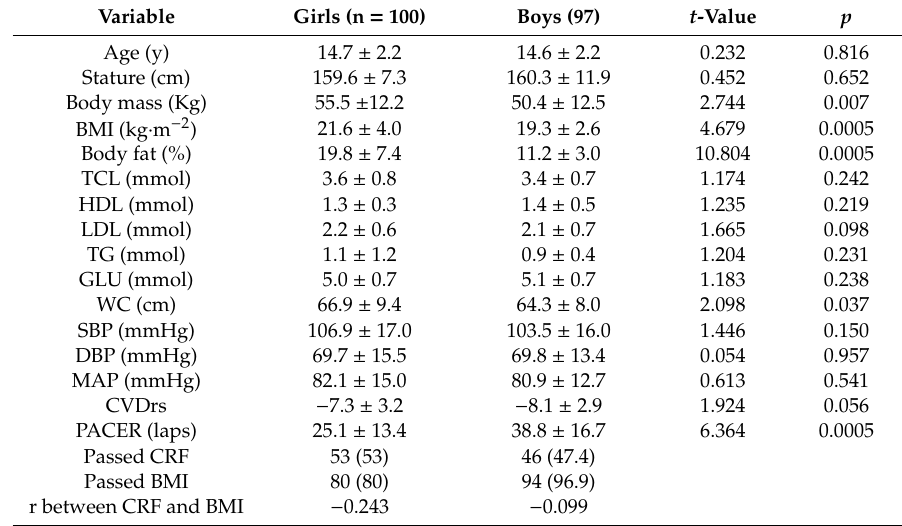
Table 1. Physical, biochemical and hemodynamic characteristics of participants according to sex (n = 197).